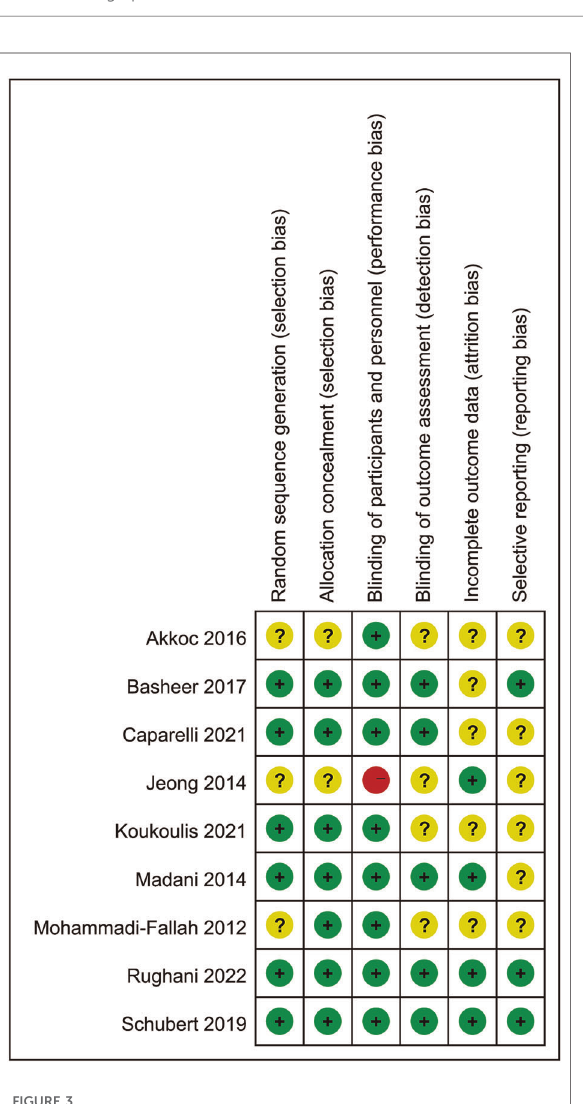
FIGURE 2 Risk of bias graph.